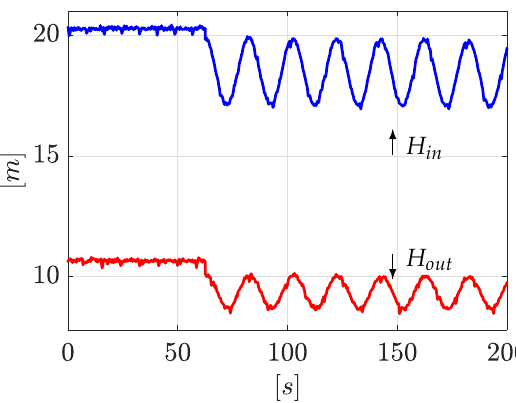
Figure 4. Pressure heads H in and H out .